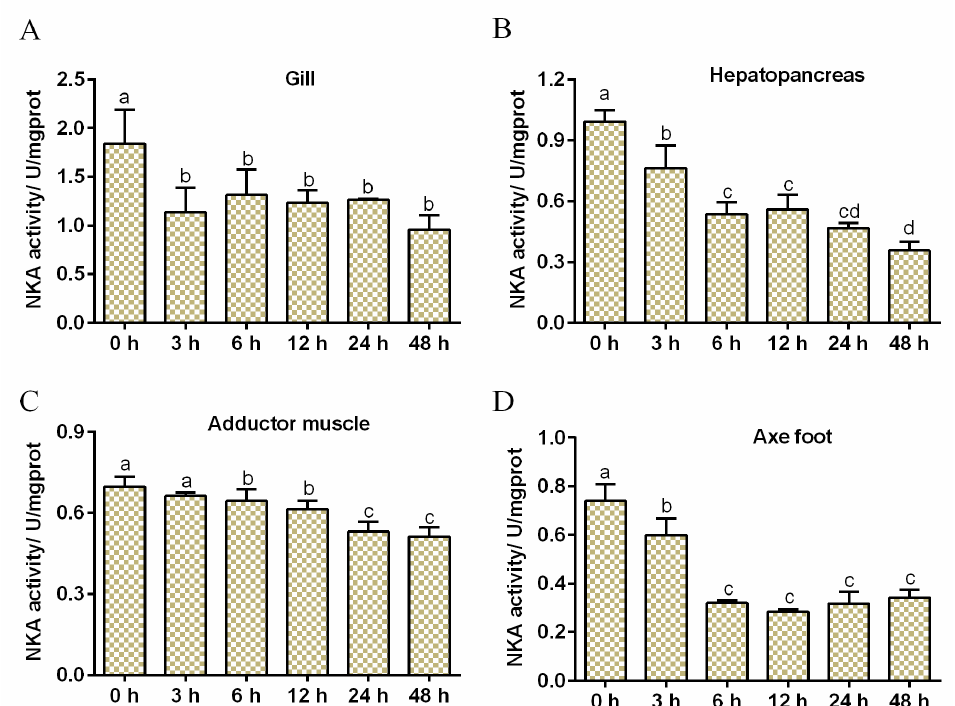
Figure 2. Effects of salinity stress on NKA activity in different tissues: ( A ) gill; ( B ) hepatopancreas; ( C ) adductor muscle; ( D ) axe foot. Data were expressed as mean ± SD ( n = 6). Different letters indicate statistical differences ( p < 0.05) between groups.